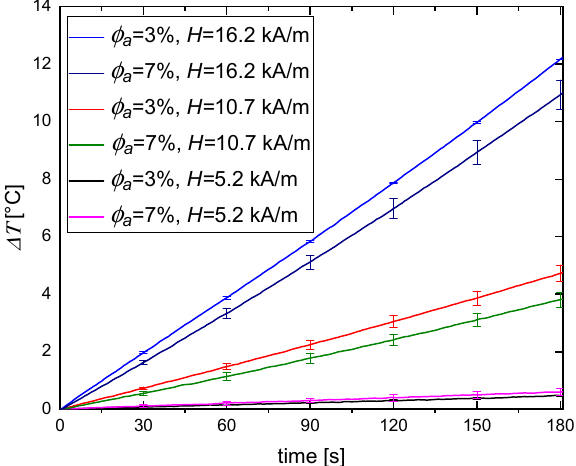
Figure 7. Temperature increase for CNPs embedded in 3% and 7% agar phantom during the heating in AMF at 5.2, 10.7, and 16.2 kA/m strength.